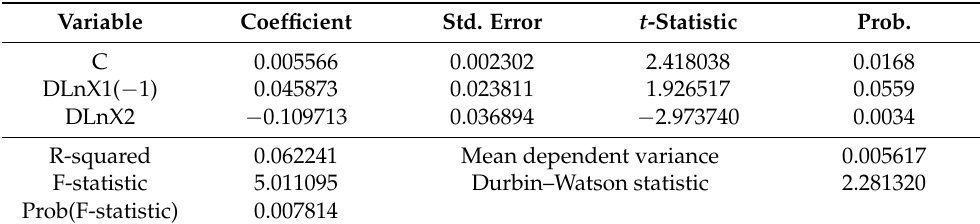
Table 2. Best model: dependent variable: DLnY. Method: least squares. Sample (adjusted): 2007M07 to 2020M04. Included observations: 154 after adjustments.